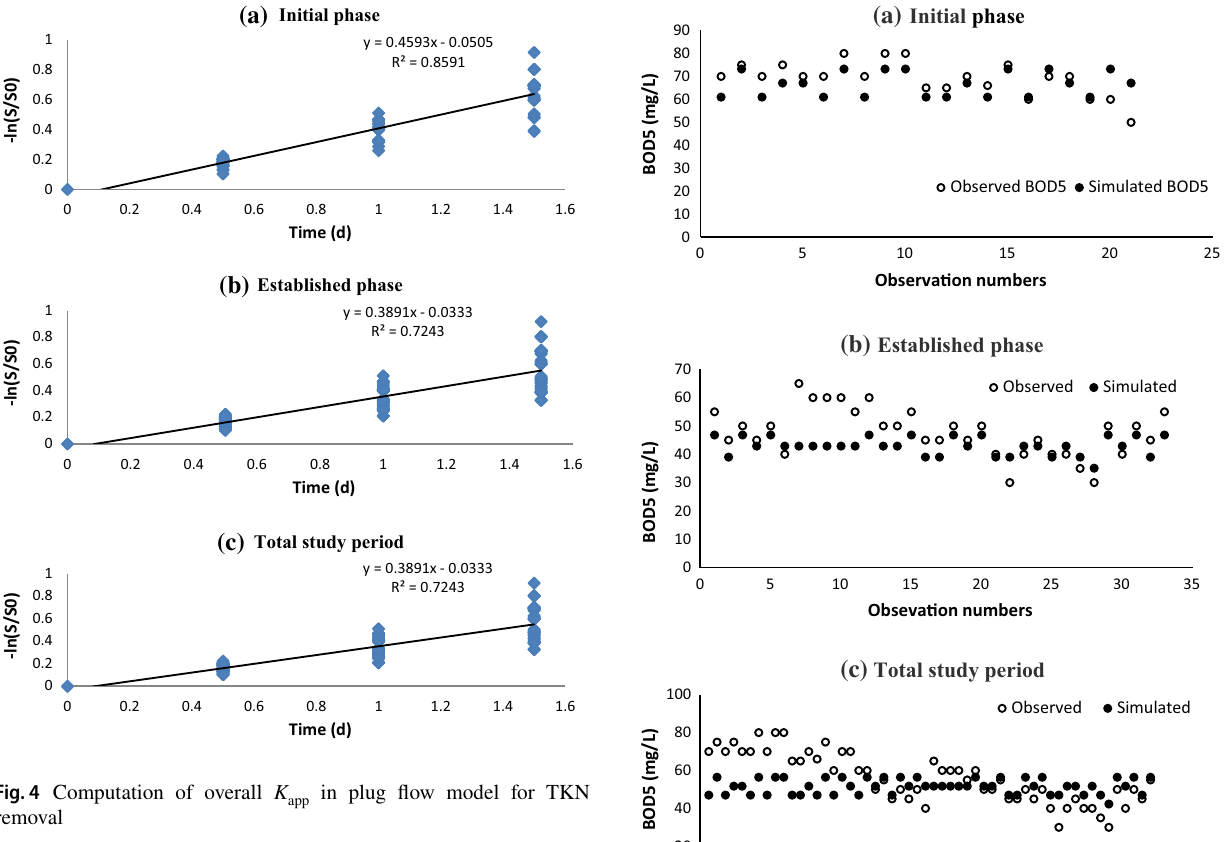
app in plug flow model for TKN